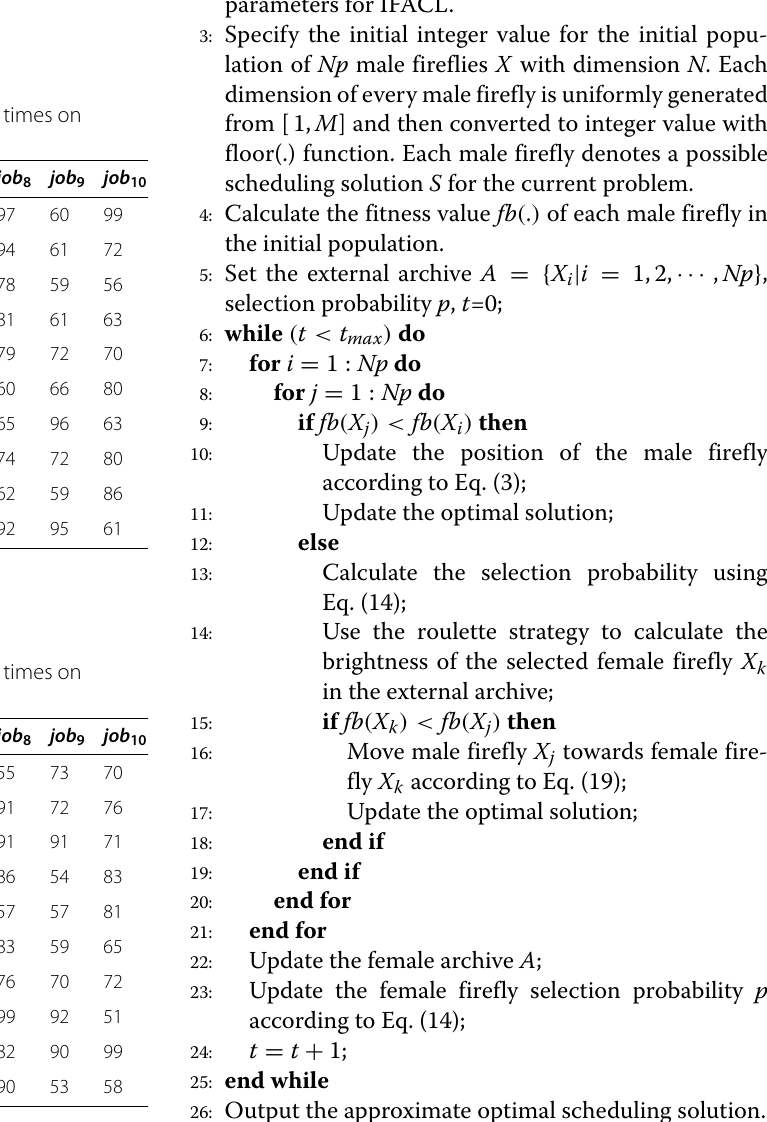
Algorithm 2 Psuedocode of the IFACL for UPMSP with sequence-dependent setup